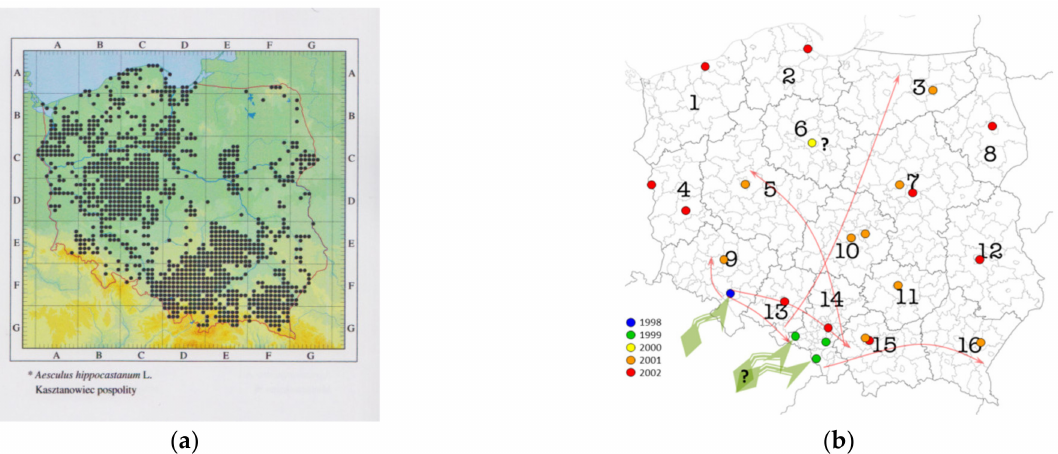
Figure 13. ( a ) A map of the distribution of the horse chestnut ( Aesculus hippocastanum ) in Poland [43]; *: each black point represents confirmed sites of A. hippocastanum in Poland; ( b ) the first recorded sites of the occurrence of Cameraria ohridella in Poland in the years 1998–2002, the arrows indicate the areas of the main directions of insect spread [35,36]-modified. 1–16: numbers assigned to individual voivodships; see Table